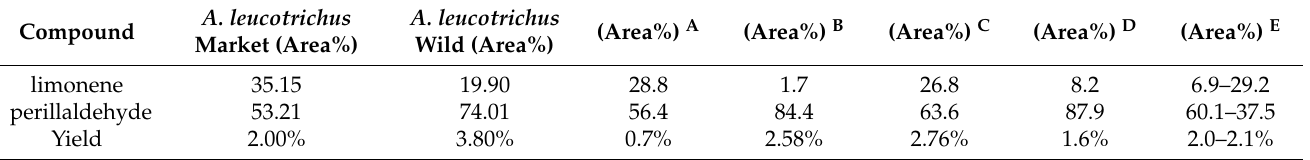
FID. 3 AI exp: linear retention indices calculated on Varian VF-5 ms column. 4 AI lit: linear retention indices [16]. The main compounds are in bold.